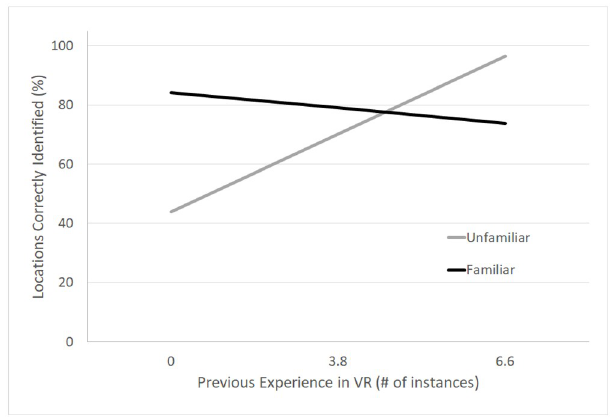
Fig 4. Accuracy for type 3 questions. Predicted values for the percentage of locations correctly identified are plotted against experience in VR for pairs in the Familiar and Unfamiliar conditions. For pairs with little experience in VR, familiar pairs performed better than unfamiliar